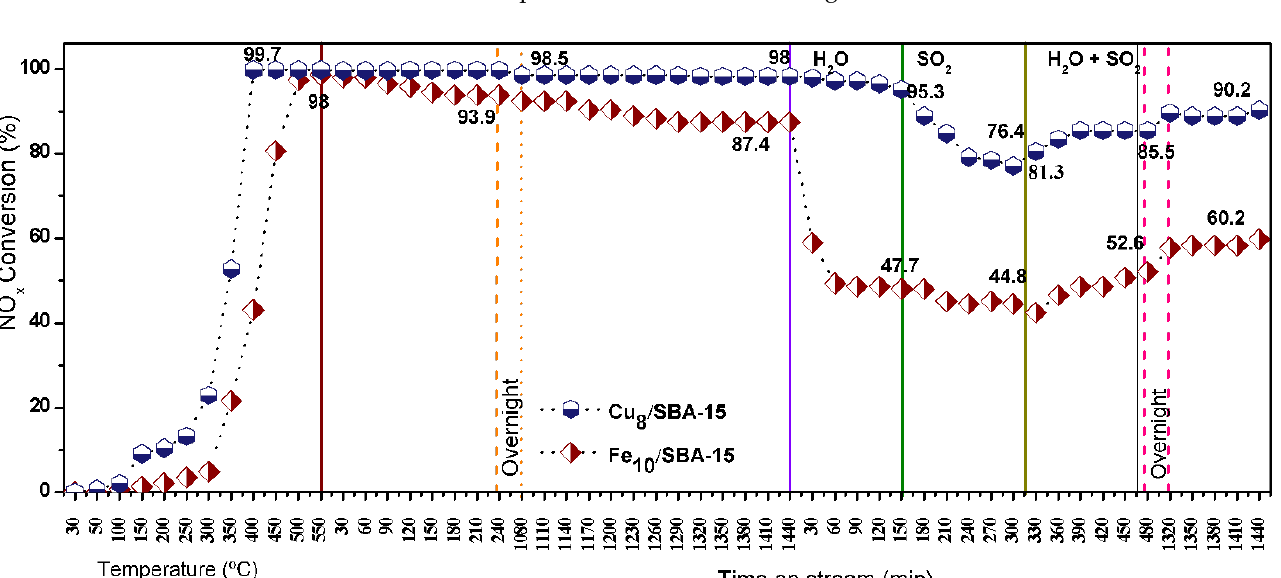
Figure 11. Long term stability runs over Cu 8 /SBA-15 and Fe 10 /SBA-15 . NO x conversions obtained in the 30 – 550 °C temperature range and time on steam intervals of 30 – 1440 min. The runs were car- ried out in presence (absence) of steam 10 wt.%, SO 2 50 ppm or both steam 10 wt.% and SO 2 50